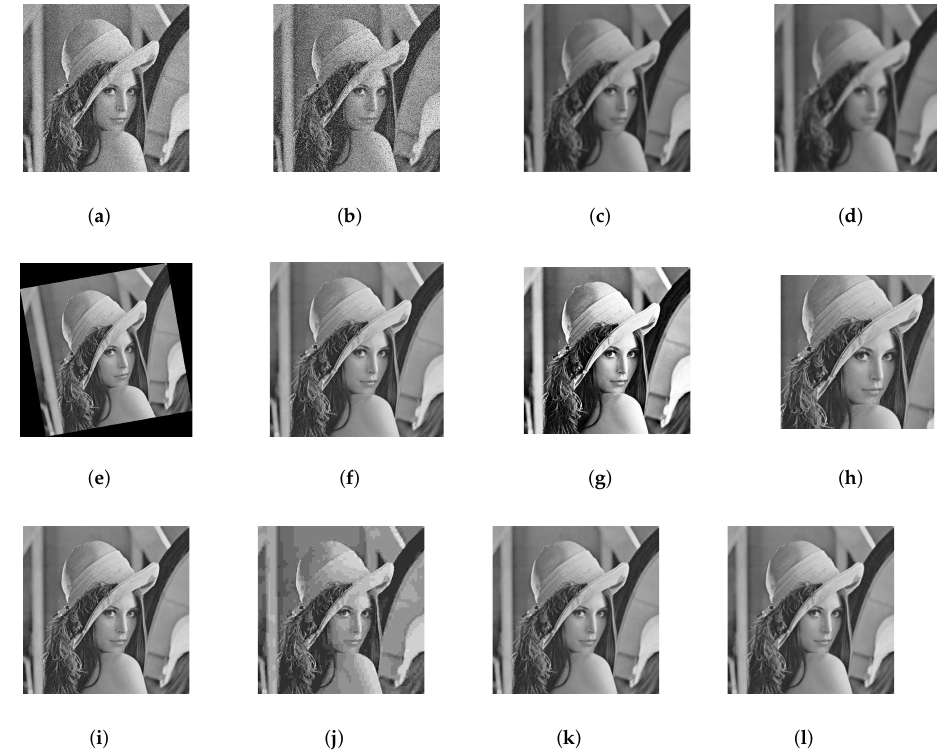
Figure 12. Sample of attacked watermarked images: ( a ) Gaussian noise addition with zero mean and standard deviation (0.01), ( b ) Salt and pepper noise with noise density 0.01, ( c ) Low-pass Gaussian filtering ( σ = 0.5,7 × 7), ( d ) Low-pass Gaussian filtering ( σ = 0.6,7 × 7), ( e ) Rotation (10 ◦ ), ( f ) Scaling (1.2), ( g ) Histogram equalization, ( h ) Cropping(25%), ( i ) JPEG compression with quality factor 60, ( j ) JPEG compression with quality factor 5, ( k ) Gaussian smoothing ( σ = 0.7,7 × 7), ( l ) Gaussian smoothing ( σ = 0.9,7 ×